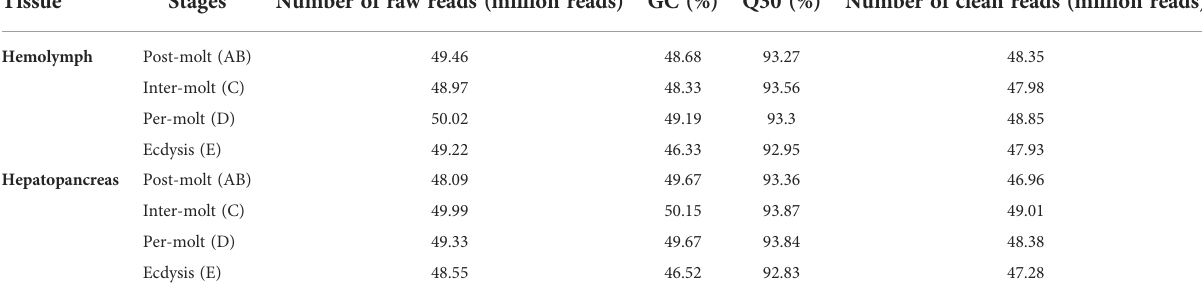
TABLE 2 Raw reads and quality control of reads for cDNA libraries of P. trituberculatus . Tissue Stages